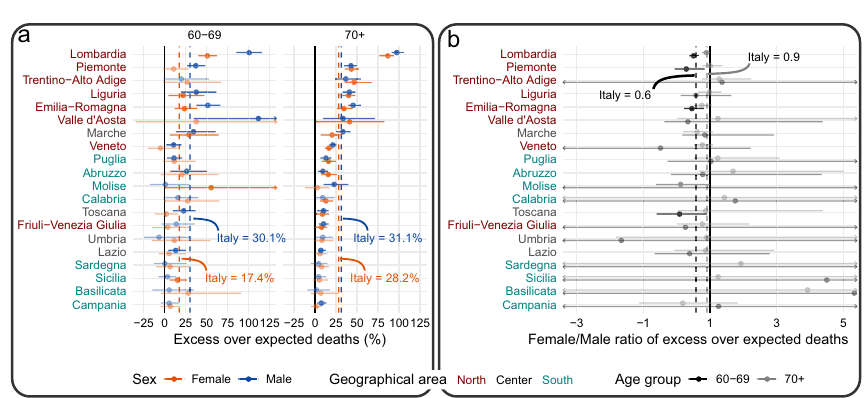
( a ) and ratio + . Geographical area South includes +